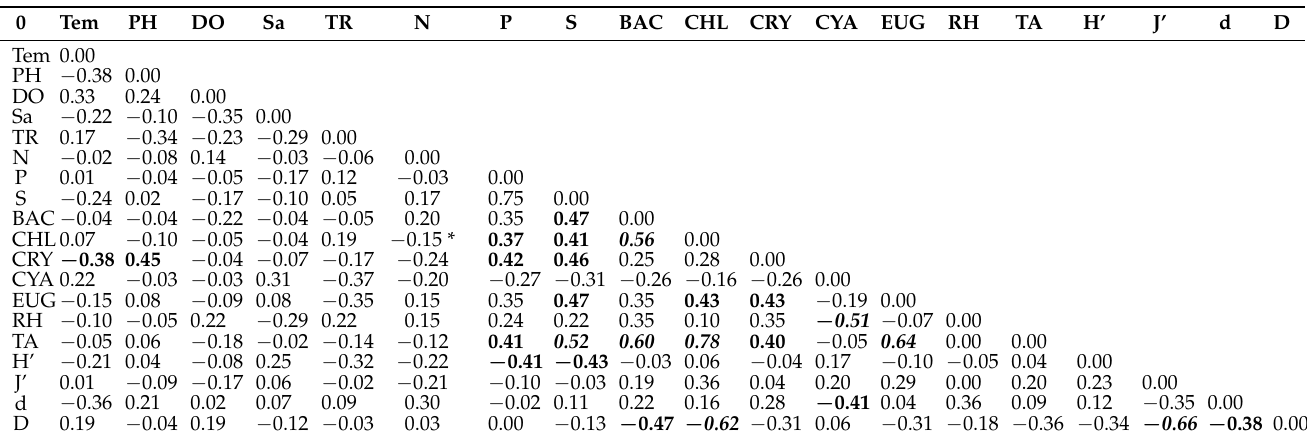
Table 2. Pearson’s correlation coefficients for physico-chemical parameters, algae abundance and diversity